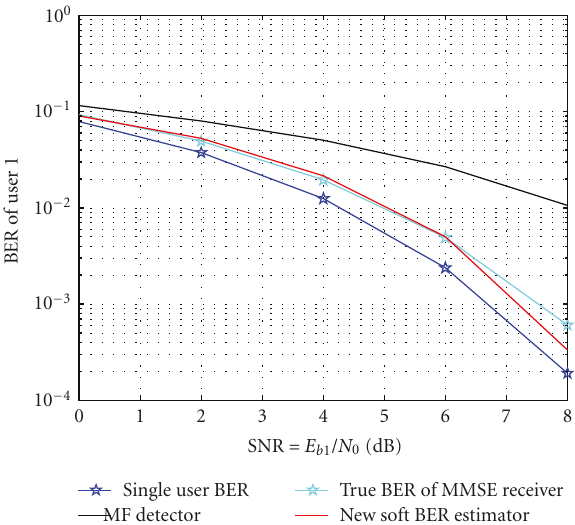
Figure 4: Soft BER algorithm and true BER comparison for synchronous MMSE-CDMA